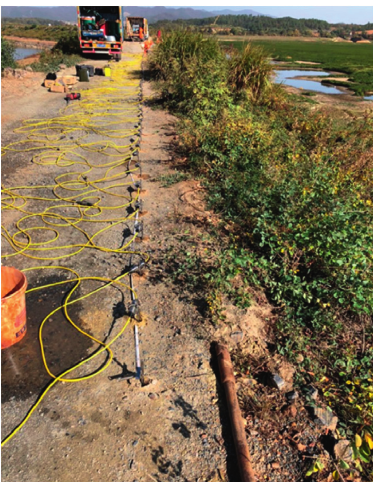
Figure 17: High density electrical detection.